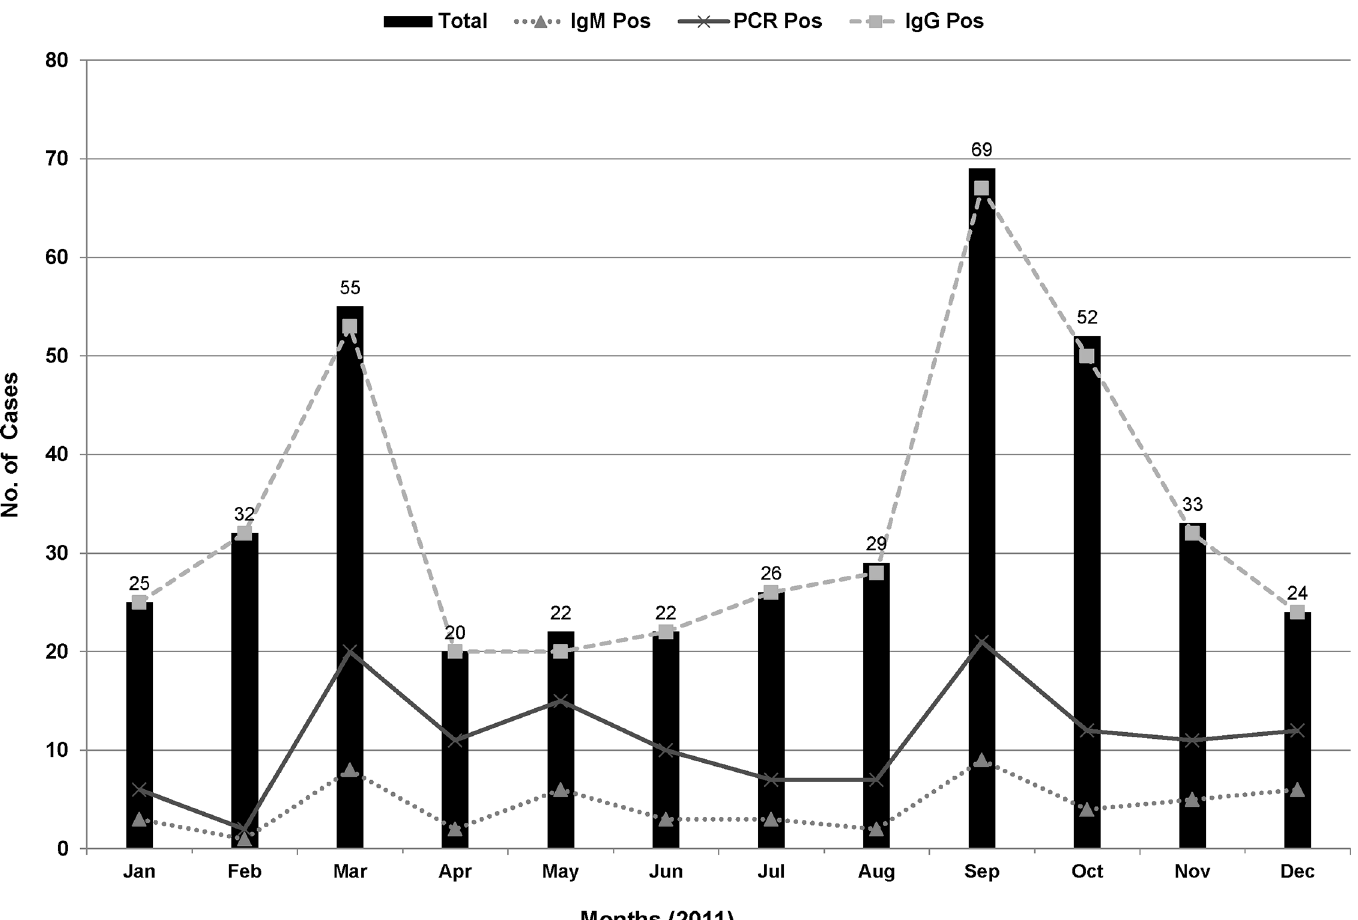
Fig 1. The distribution of HCMV positive cases in study population during 2012. The months are given on X-axis. The data labels on Y-axis indicate the number of total and positive cases across the year. The solid black line indicates total number of cases while the number of positive cases for each assay indicated with different